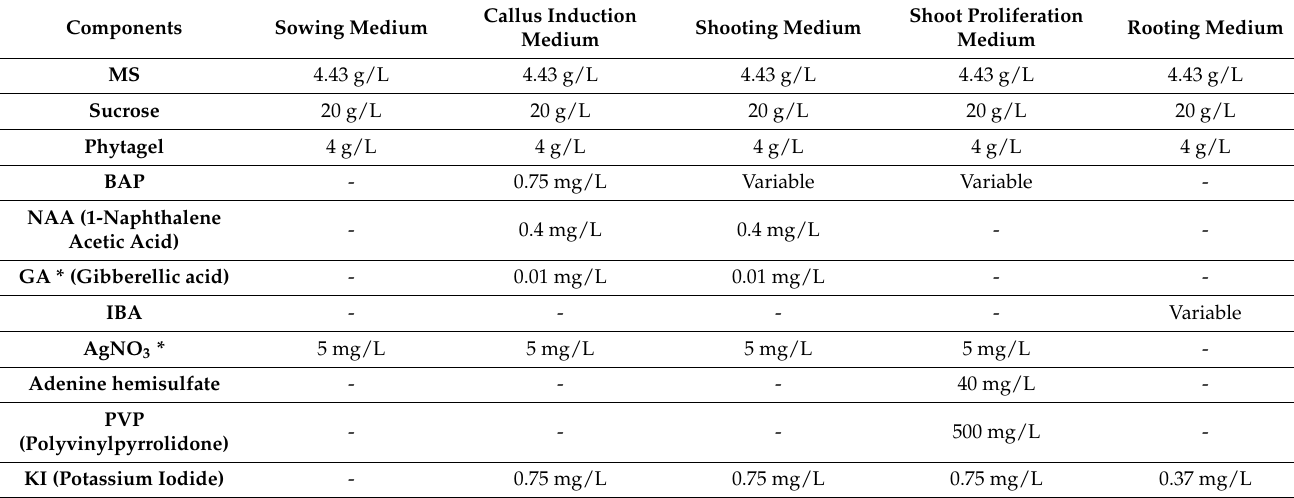
Figure 2. Mean comparison graphs for the B. rapa cv. UAF11, and B. rapa cv. Toria. Table 1. Growth regulators used in in-vitro regeneration